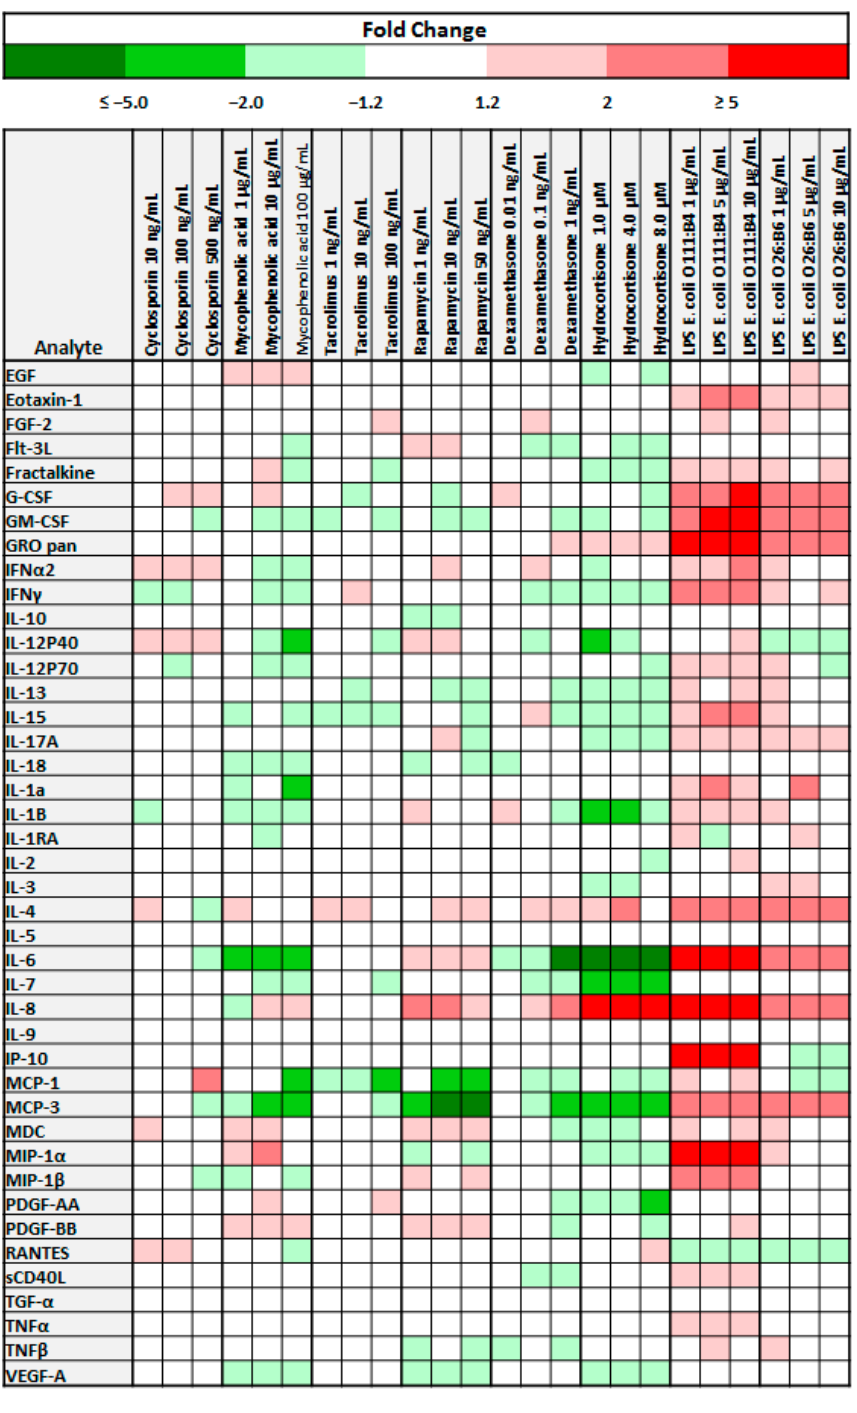
Figure 1. Cytokine secretion profiles for bone marrow-derived MSCs (BMSCs) treated with immunosuppressive medications or lipopolysaccharides (LPS). Heat Map of combined fold change in cytokine secretion for three cell lines (BMSC22, BMSC32 and BMSC34) after 3 days of coculture with immunosuppressants or LPS. EGF—epidermal growth factor, FGF-2—fibroblast growth factor-2, Flt3L—Fms-related tyrosine kinase 3 ligand, G-CSF—granulocyte–colony-stimulating factor, GM-CSF—granulocyte macrophage colony stimulating factor, IFN—interferon, IL—interleukin, MCP—monocyte chemoattractant protein, MDC—macrophage-derived chemokine, MIP—macrophage inflammatory protein, PDGF—platelet-derived growth factor, TGF—transforming growth factor, TNF—tumor necrosis factor, VEGF—vascular endothelial growth factor.